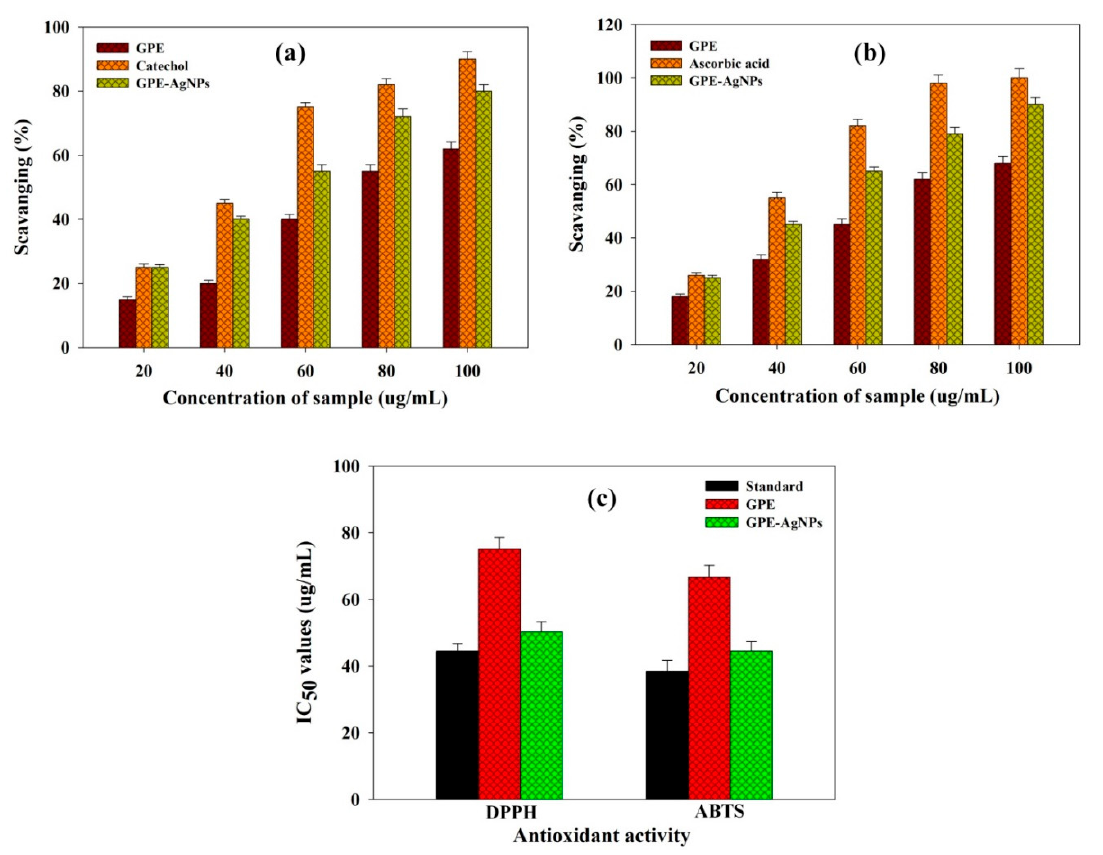
Figure 4. Percentage of ( a ) 2,2-diphenyl-1-picryhydrazyl (DPPH), ( b ) 2,2 (cid:48) -Azino-bis(3-ethylbenzothiazoline)-6 sulfonic acid (ABTS) radical scavenging potential by GPE, standard catechol, and biosynthesized GPE-AgNPs at various concentration, and their ( c ) IC 50